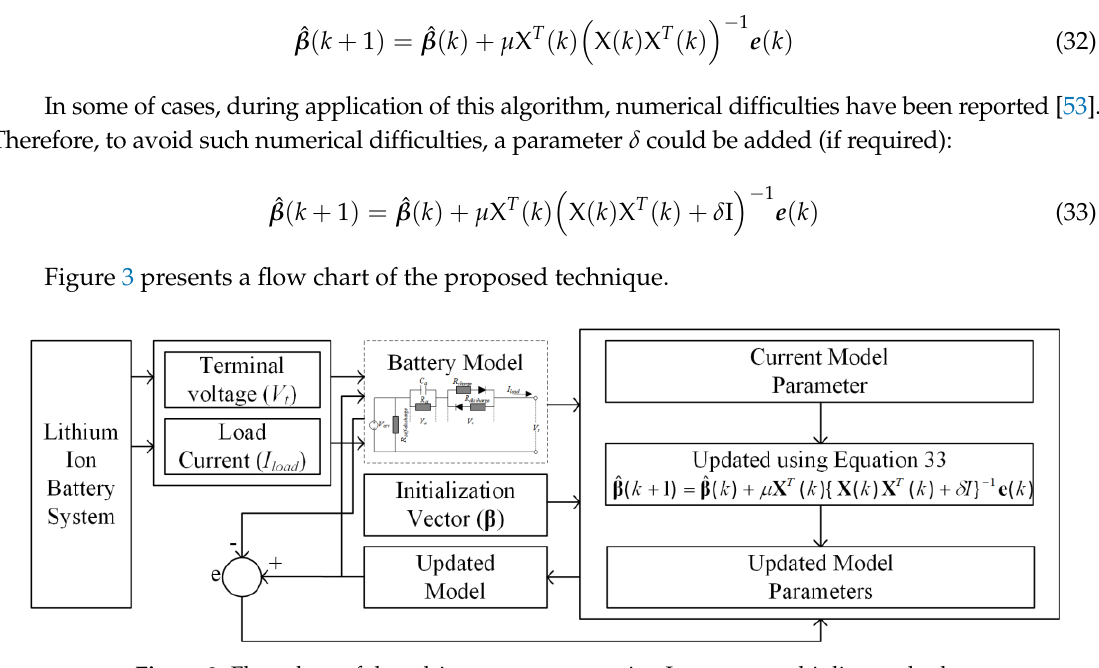
Figure 3. Flow chart of data driven parameters using Lagrange multiplier method.